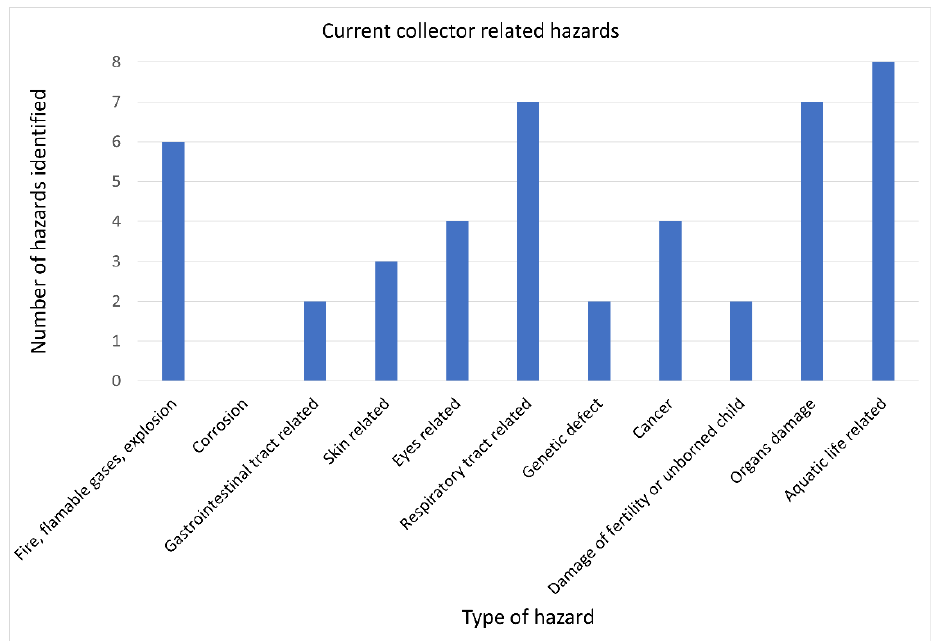
Figure 9. The number of the hazards identified versus the type of hazard for current collector materials in Mg–S cells.